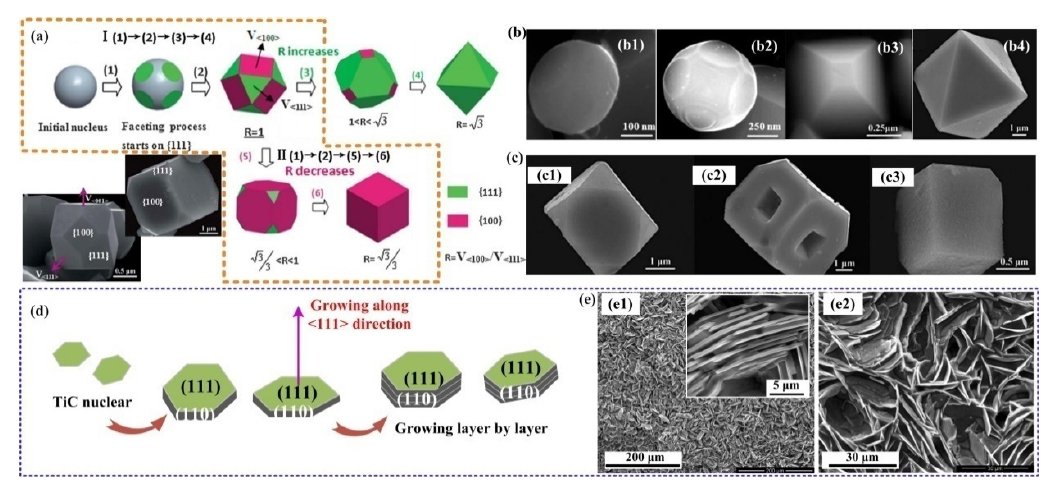
Figure 13. ( a ) TiC morphology evolution model schematic illustration in Al-Ti-C (Route I) and Al-Ni-Ti-C systems (Route II). (100) and (111) faces are shown in green and purple, respectively. ( b ) The possible morphology of TiC x in the Al-Ti-C melt. ( c ) The morphology of TiC x under the influence of Ni, with permission from Reference [15], copyright (2012) Royal Society of Chemistry. ( d ) Hexagonal TiC platelet growth schematic illustration. ( e ) TiC platelets ( e1 ) formed on the surface of the Ti/Si/TiC/Al 0.2 sample (obtained after 1500 °C sintering for 10 min in Ar atmosphere) and ( e2 ) on the surface of Ti/Si/Al 0.2 (obtained after 1450 °C sintering for 10 min), with permission from Reference [16], copyright (2008) Elsevier.